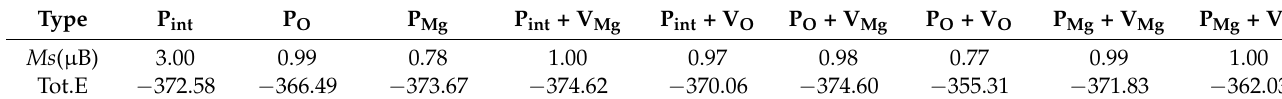
Table 2. Magnetic moment of different defect configurations in P-implanted MgO.